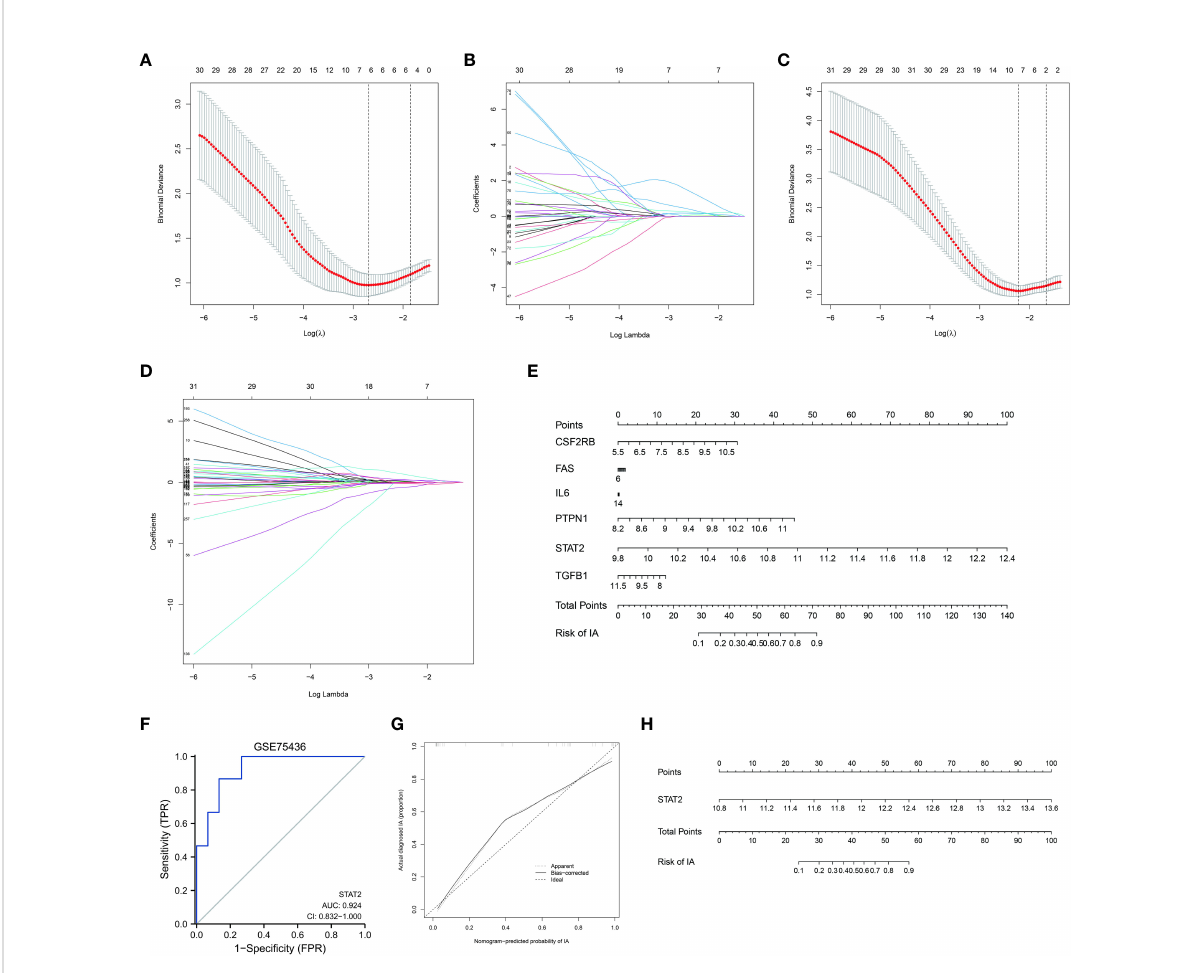
FIGURE 3 Selecting and validating characteristic genes (A, B) Investigation of the characteristic genes of the IL6/JAK/STAT signaling pathway (ISP) by the least absolute shrinkage and selection operator (LASSO) regression. (C, D) Investigation of the characteristic genes of the estrogen response pathway (ERP) by LASSO regression. (E) Nomogram based on the characteristic genes of ISP. (F) Validation of the diagnostic ef fi cacy of STAT2 for intracranial aneurysm (IA) by the receiver operator characteristic (ROC)analysis. (G) Predictive accuracy of STAT2 for IA by the calibration curve. (H) Nomogram based on STAT2 as diagnostic tool for IA